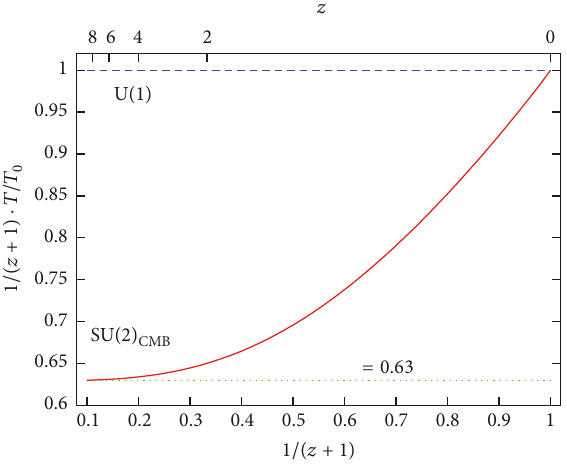
Figure 1: The 𝑇 - 𝑧 scaling relation 𝑇/(𝑇 0 (𝑧+1)) in SU (2) Note the emergence of 𝑇/𝑇 0 = 0.63(𝑧 + 1) for 𝑧 ≳ 9 (dotted). The conventional U( 1 ) theory for thermal photon gases associates with the dashed line. Data taken from [27] after slight and inessential